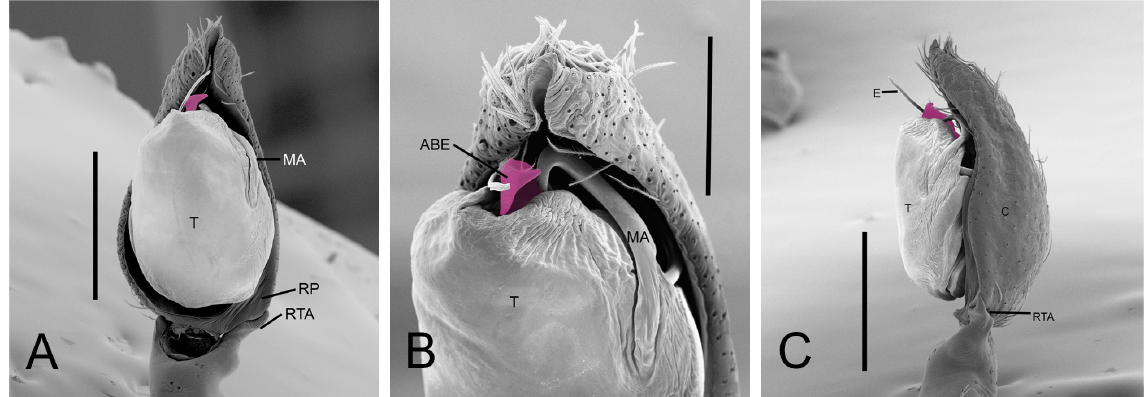
Fig. 23. Tafana silhavyi (Caporiacco, 1955), ♂ (MNHN 13312). A . Left palp, ventral view. B . Left palp, frontal view. C . Left palp, retrolateral view. Abbreviations: ABE = apophysis of base of the embolus; C = cymbium; E = embolus; MA = median apophysis; RP = retrolateral projection; RTA = retrolateral tibial apophysis; T = tegulum. Scale bars: A, C = 0.4 mm; B = 0.2